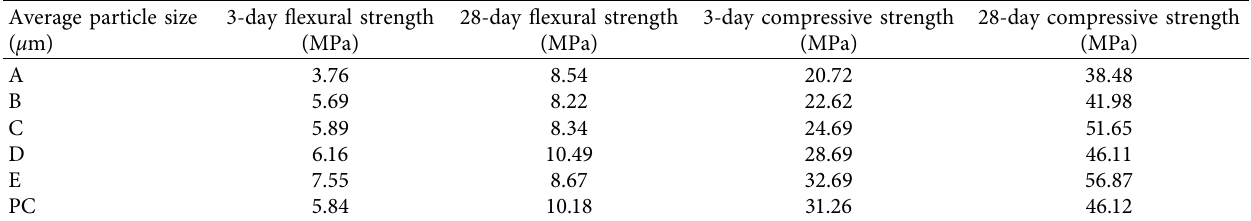
Table 7: Influence of PPA with different fineness on flexural and compressive strength of cement mortar.